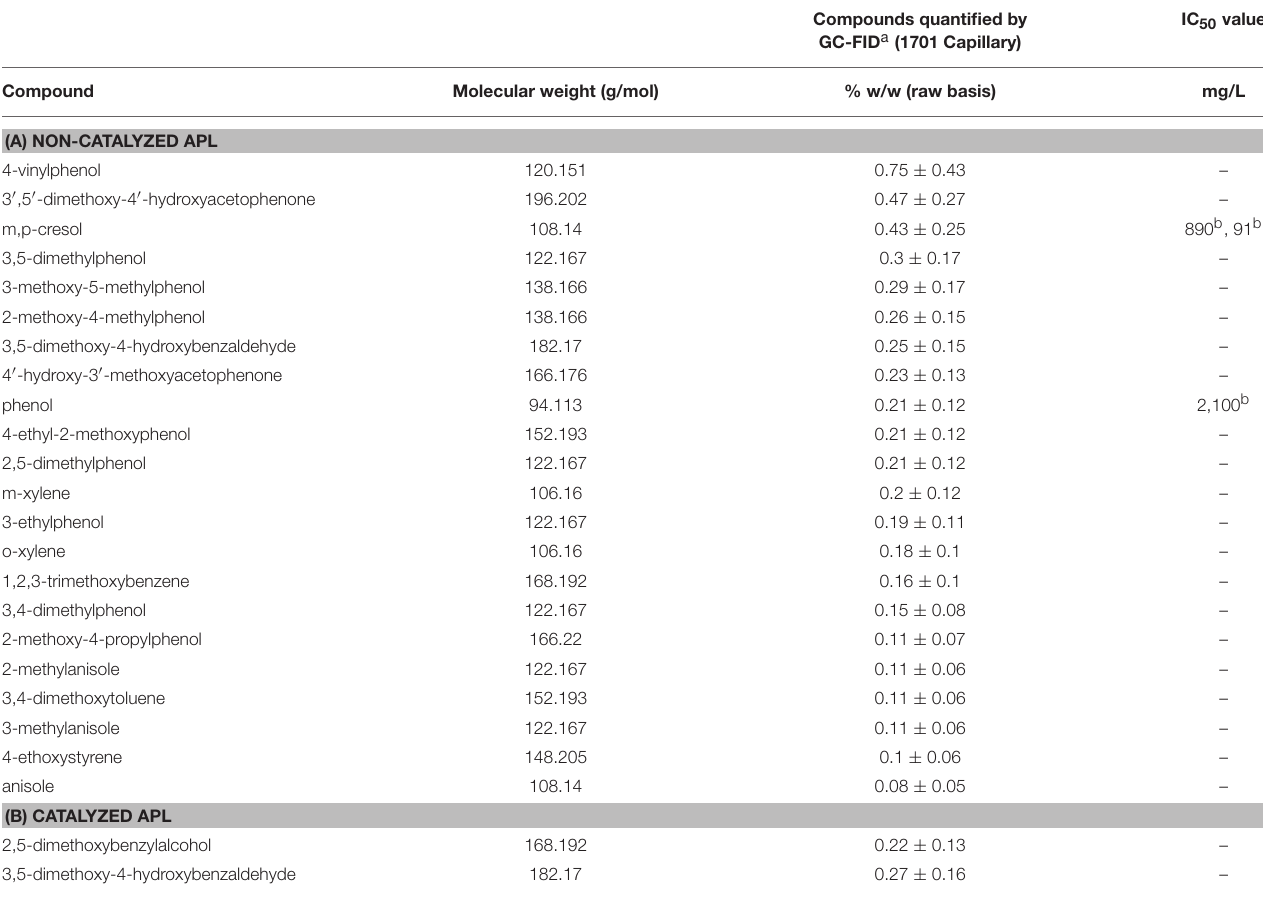
TABLE 4 | Air-stripped APL compounds quantified by